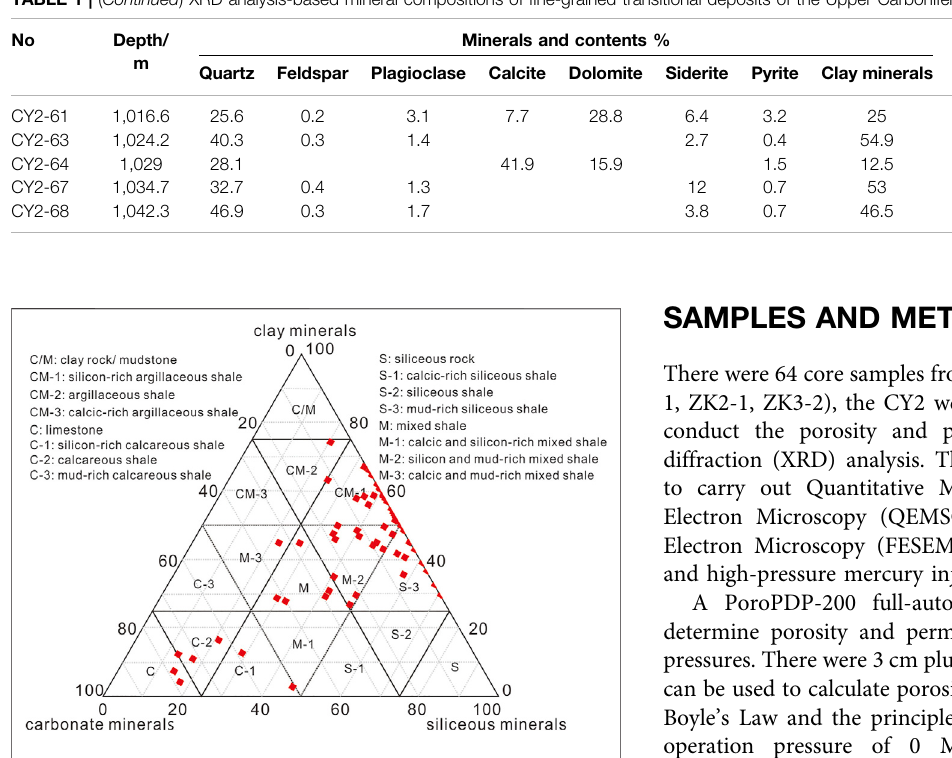
FIGURE 4 | Mineral composition of the Upper Carboniferous Keluke fi ne-grained transitional deposits determined by XRD, showing mixed sedimentary